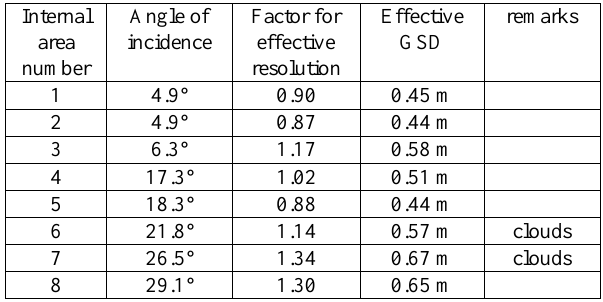
Table 5: Effective GSD of SkySat Collect orthoimages